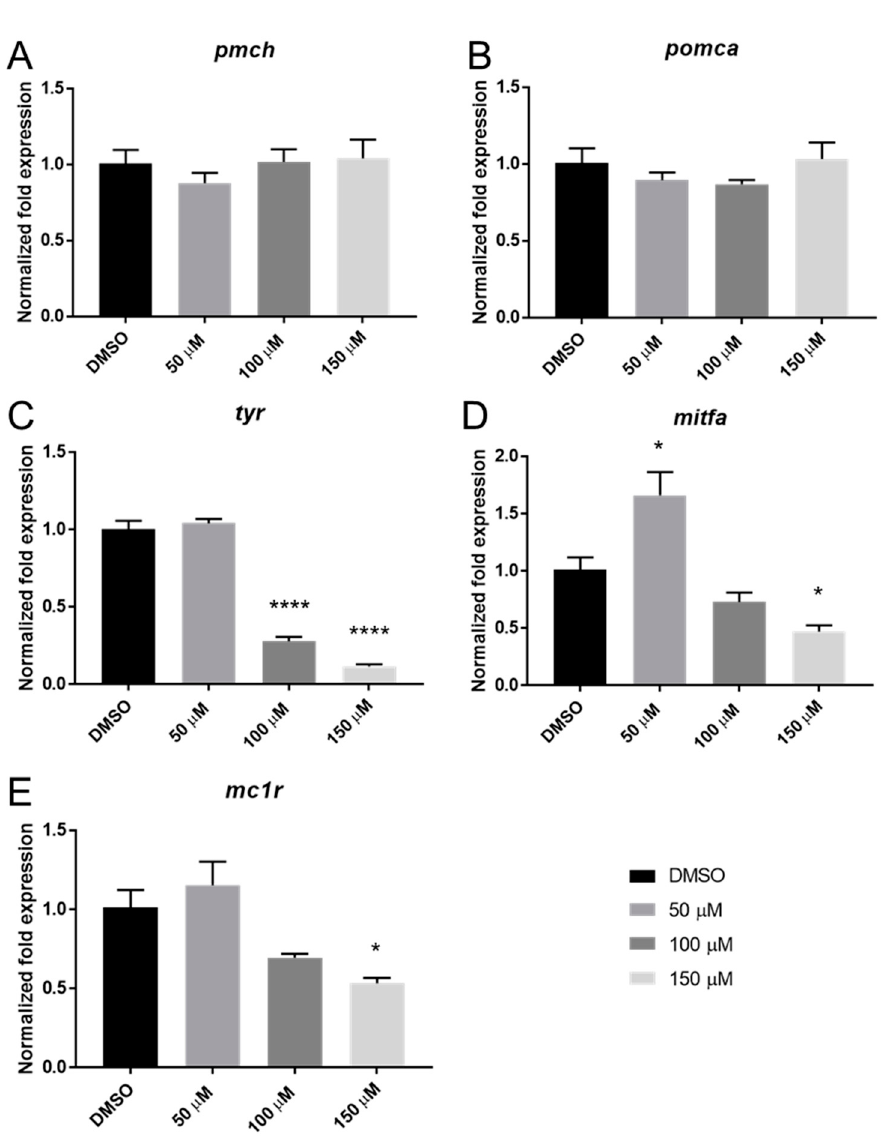
Figure 4. Effects of 72–120 hpf exposure to catechol on melanocyte-related gene expression. In total, 72 hpf embryos were treated for 48 h in DMSO or catechol, and then the gene expression of pmch ( A ), pomca ( B ), tyr ( C ), mitfa ( D ) and mc1r ( E ) were analyzed by qPCR at 120 hpf. * p < 0.05; **** p < 0.0001. One-way ANOVA with Bonferroni’s post hoc test. For the purposes of clarity, statistical significance is only shown when a difference is significant compared to DMSO control.